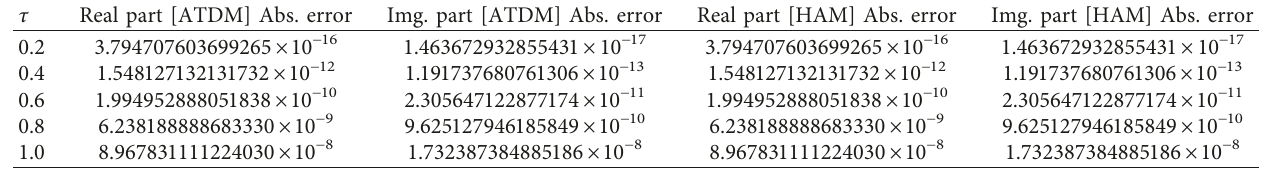
Table 4: The absolute error in ATDM and HAM for Example 4 at ] � 1.